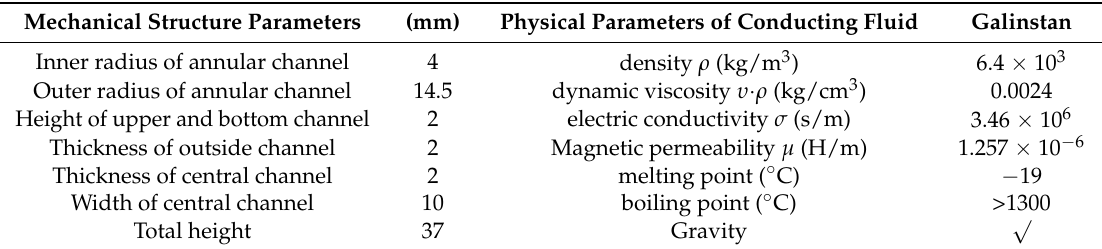
Table 1. Main mechanical structure parameters and physical parameters of the fluid channel.